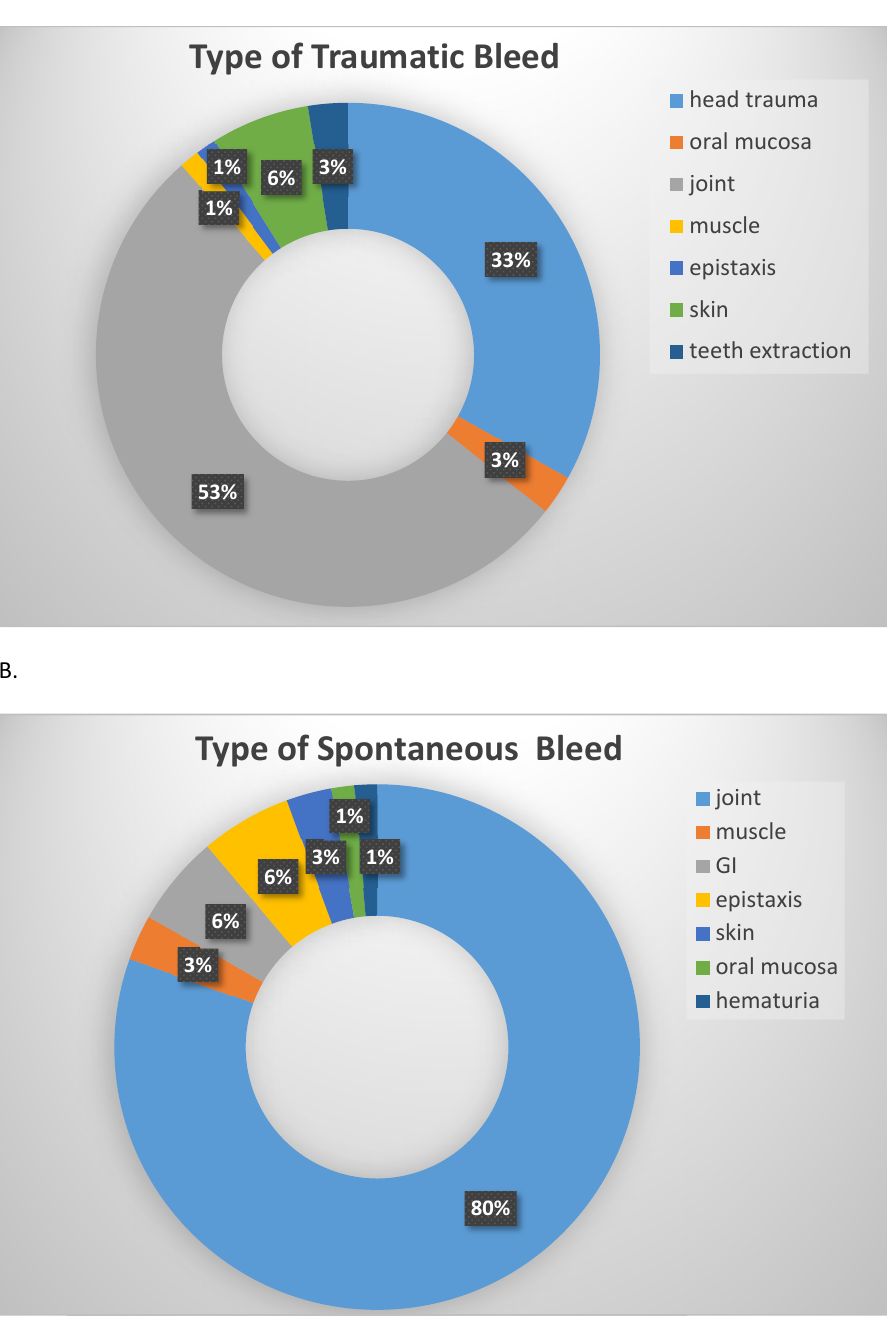
Figure 3. Location of traumatic and spontaneous bleeds. ( A ) Trauma-related bleeds. % of the different types of bleeds, each color is a different type of bleed. ( B ) Spontaneous bleeds. % of the different types of bleeds, each color is a different type of